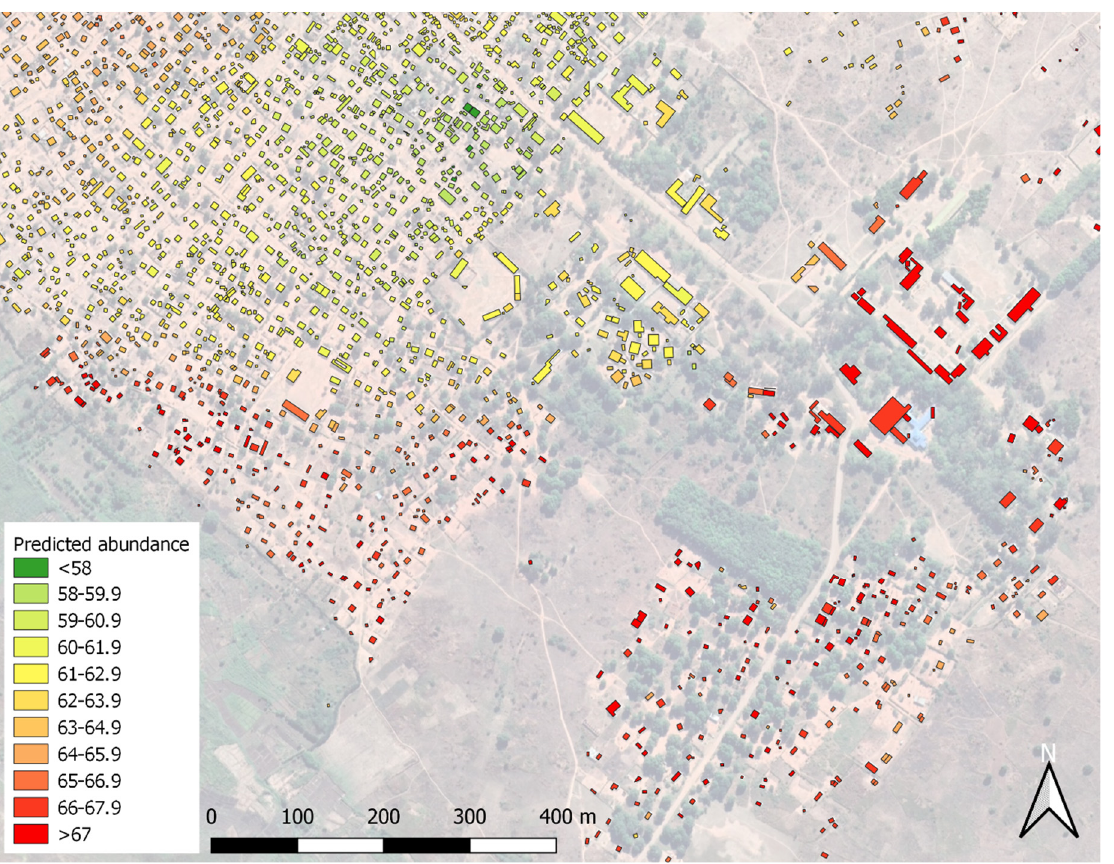
Figure 9. Example of varying estimated An. gambiae s.l. abundance for individual buildings for an area of Kapolowe in February 2017.